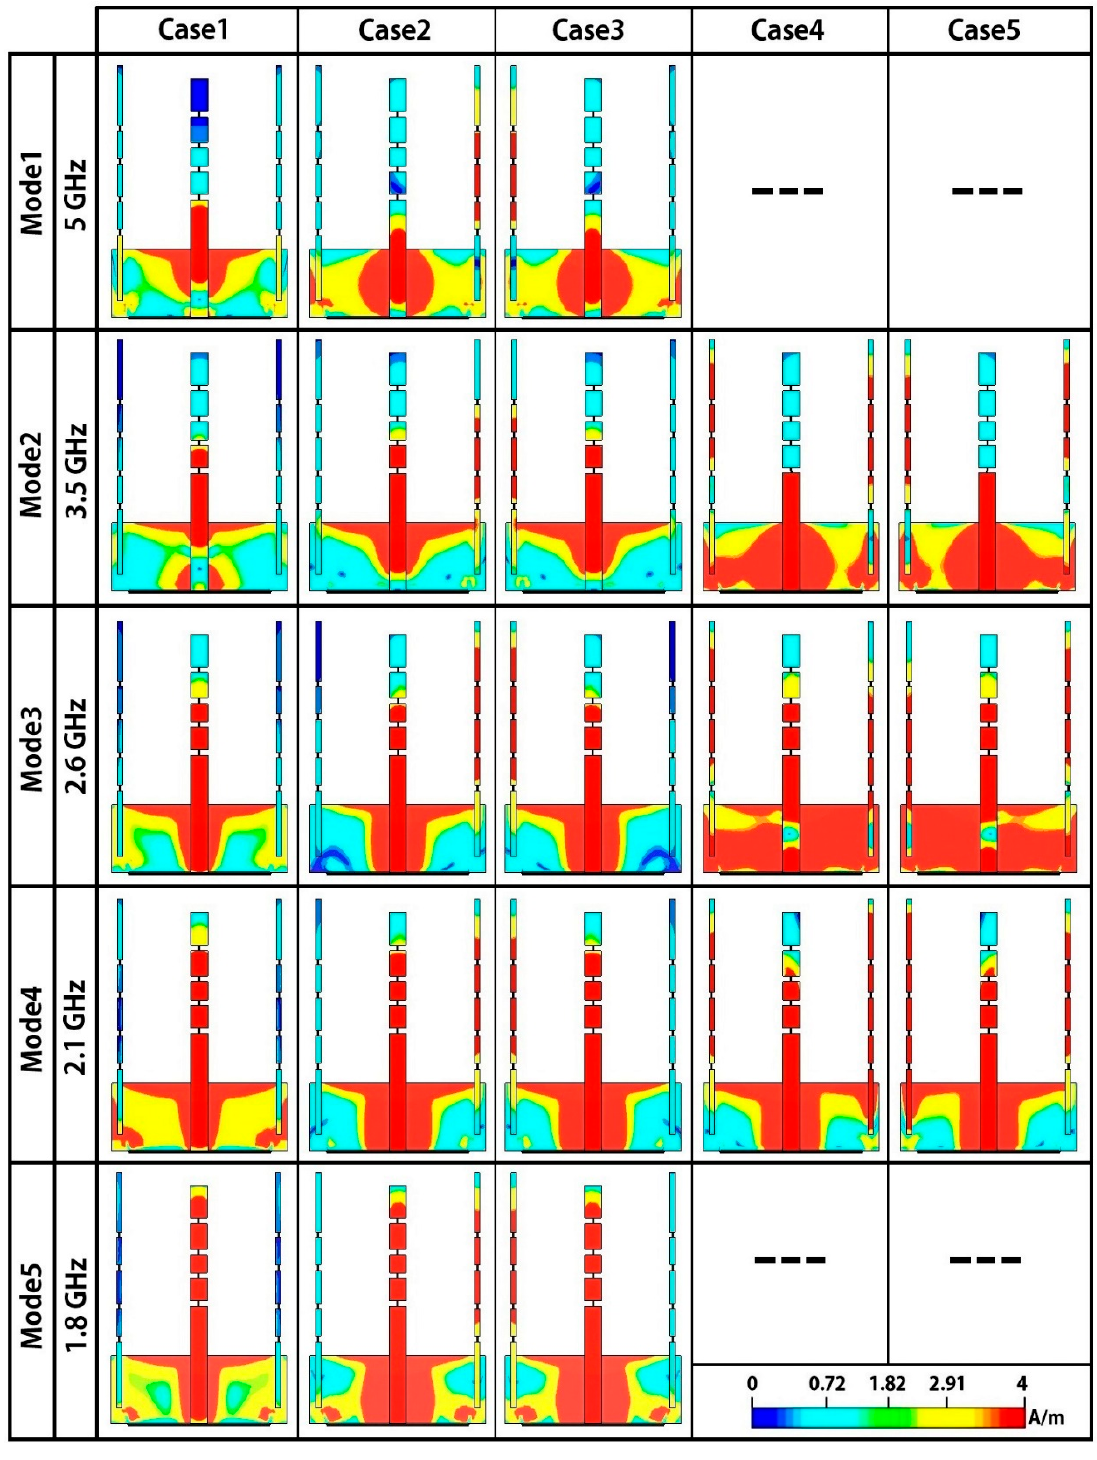
Figure 12. Surface currents distribution of all modes.